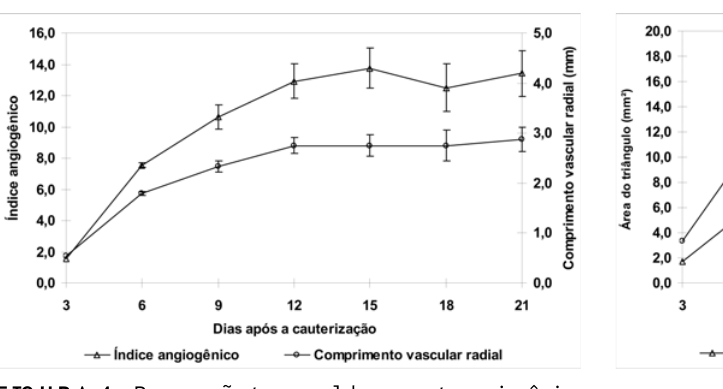
FIGURA 5 – Progressão temporal da resposta angiogênica segundo os quantificadores área do triângulo de neovascularização e área do setor de coroa circular. Valores expressos como média ± erro padrão da